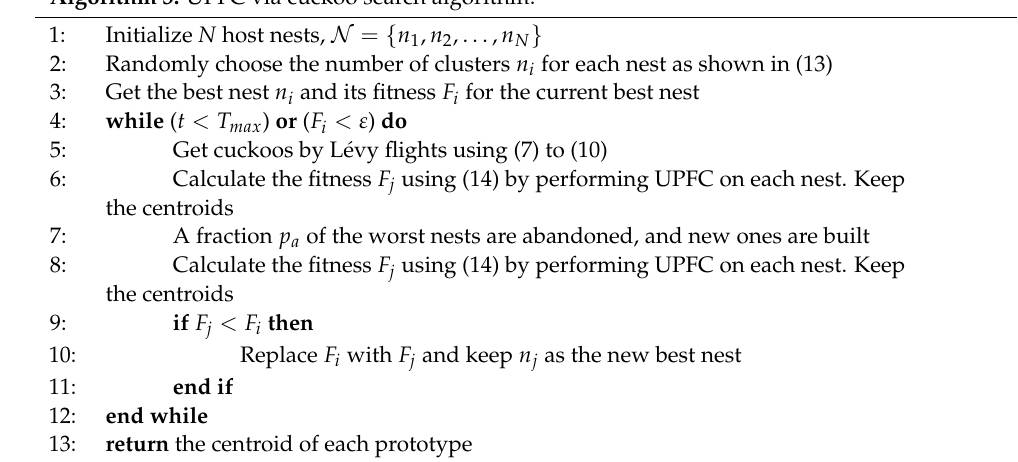
Algorithm 3. UPFC via cuckoo search